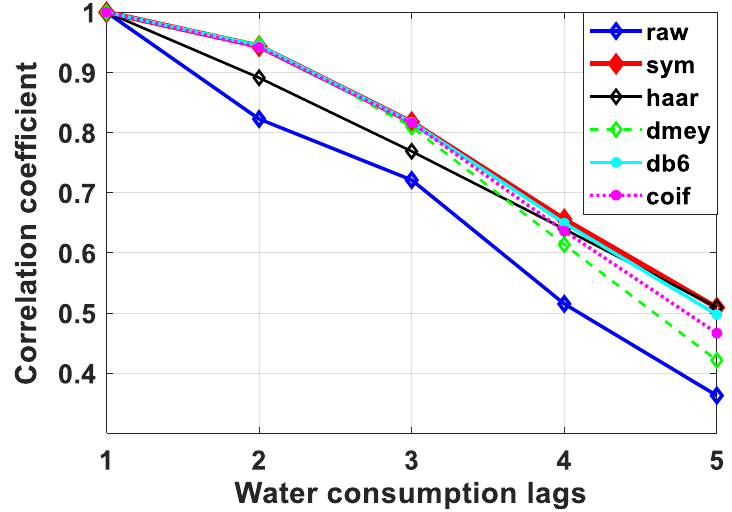
Figure 4. The correlation coefficients of lags water consumption (raw and denoising with five types of wavelets).